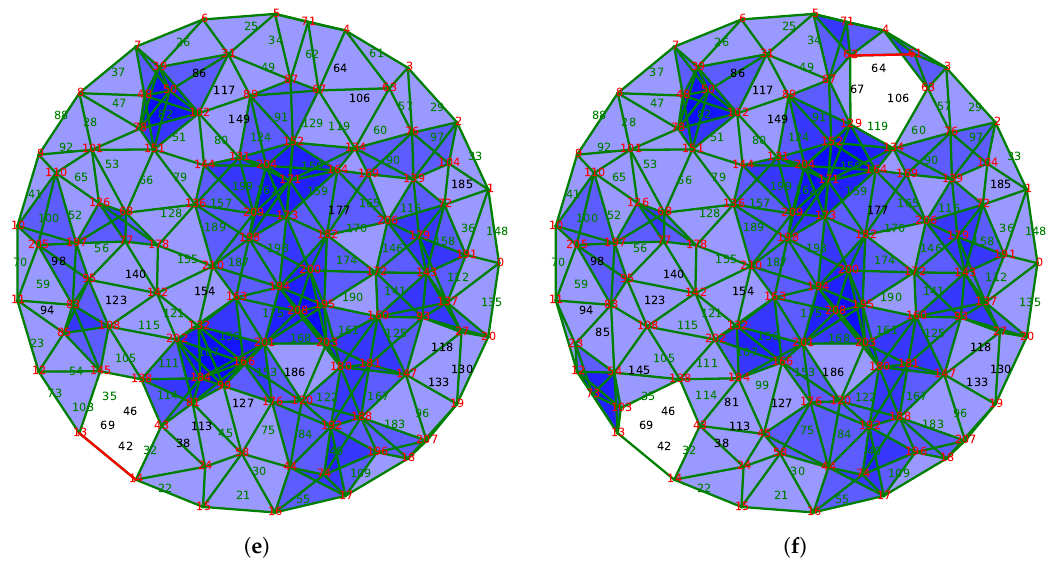
Figure 11. Snapshots of awoken and asleep sensors at iteration number ( a ) 1; ( b ) 2; ( c ) 20; ( d ) 21; ( e ) 23 and ( f )